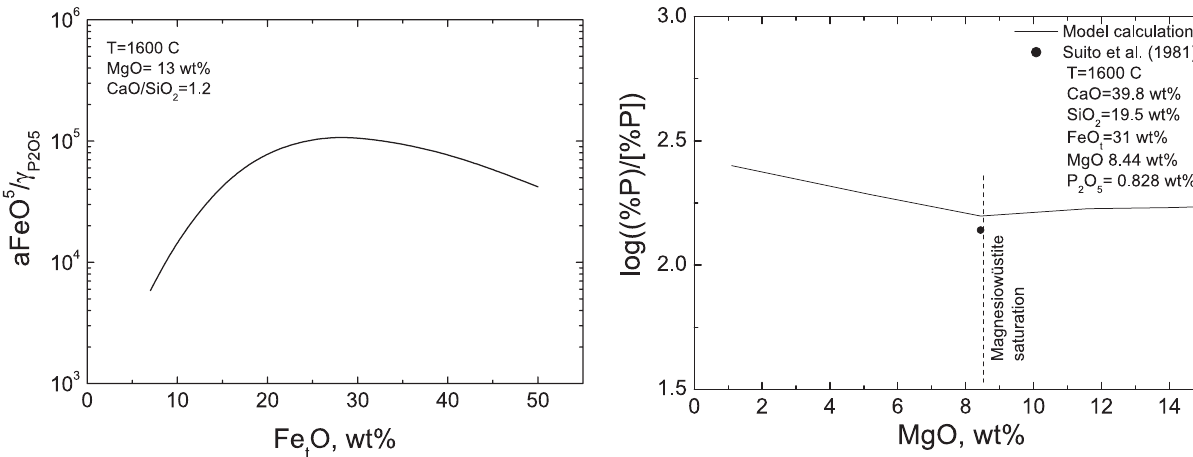
Fig. 11: The effect of MgO content on the phosphorus distribution between the slag and metal.